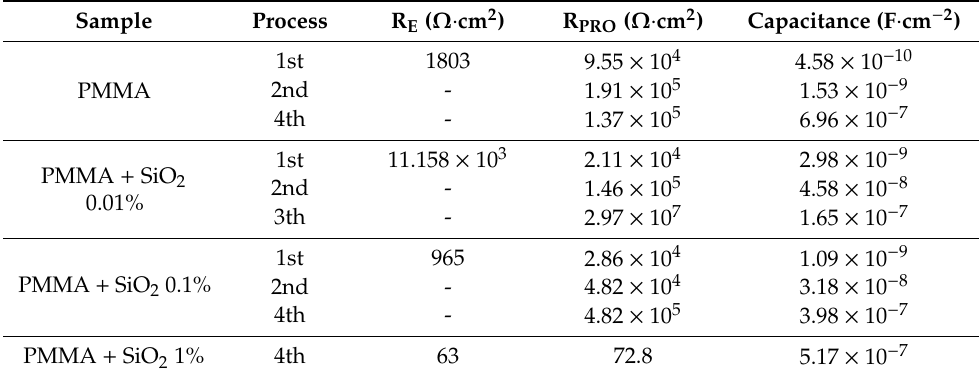
Table 2. EIS parameters for the PMMA and PMMA + SiO 2 coatings in synthetic seawater with an artificial defect on the surface.